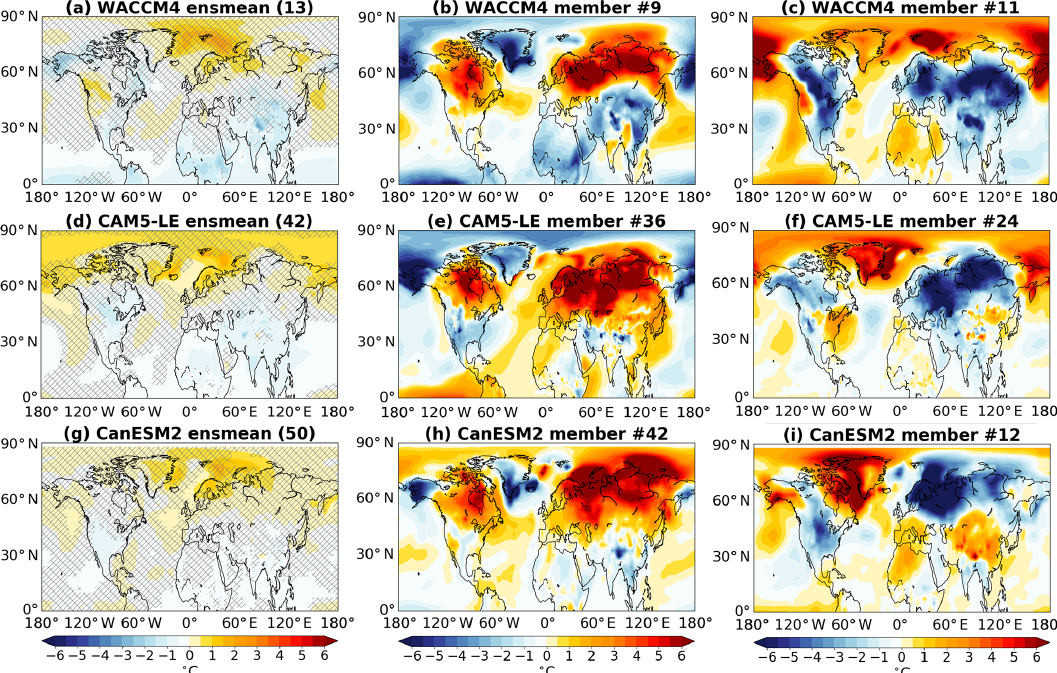
Figure 3. Wintertime surface air temperature anomalies ( ◦ C) as simulated by WACCM4 (a, b, c) , CAM5-LE (d, e, f) and CanESM2 (g, h, i) following the 1991 Mt. Pinatubo eruption. (a, d, g) The ensemble mean for each model (with the number of ensemble members in parentheses), and hatching over areas where the anomalies not significant at the 95% confidence level. (b, e, h) Individual members exhibiting extreme warming over the NH continents for each model. (c, f, i) Individual members exhibiting extreme